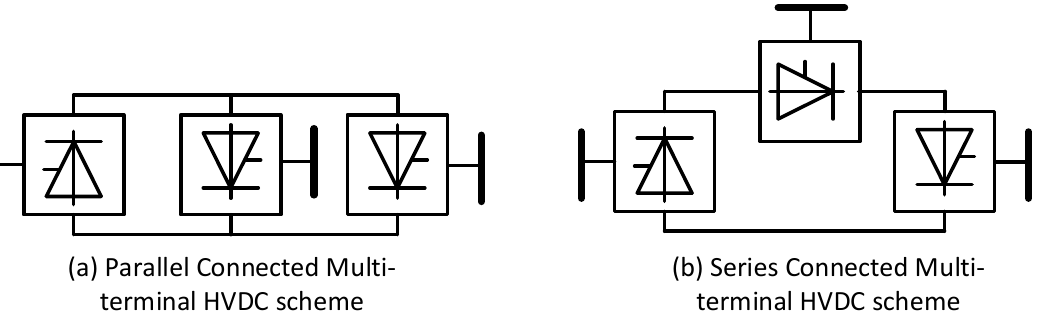
Figure 11. Multiterminal HVDC schemes: ( a ) Parallel connected; ( b ) Series